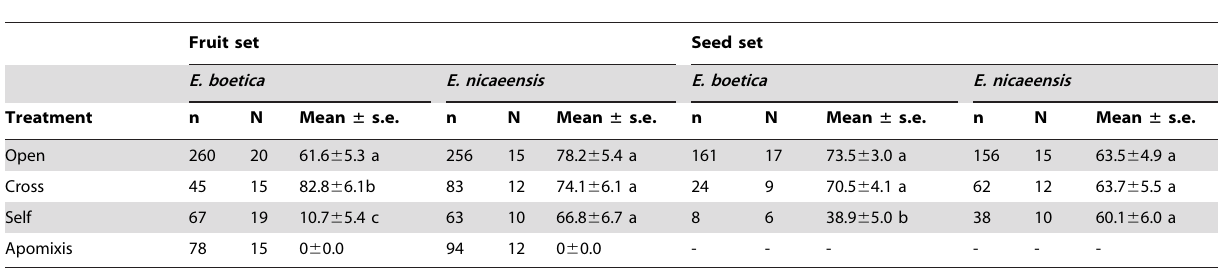
Table 3. Results of the breeding experiments on E. boetica and E. nicaeensis .